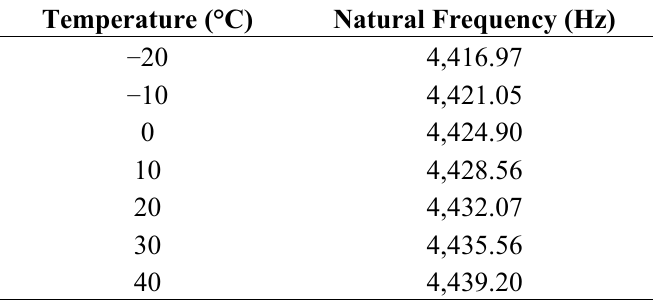
Table 1. Different natural frequencies of HRG in correspondence with different